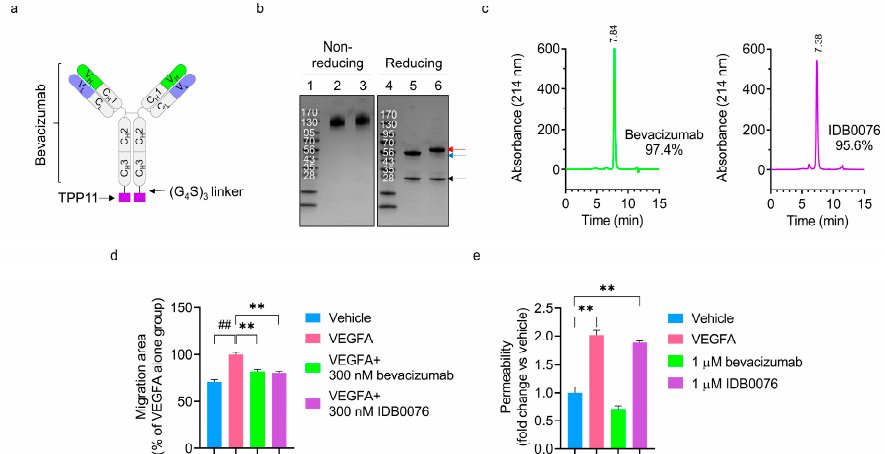
Figure 1. IDB0076 was produced in CHO-DG44 cells and characterized in comparison with bevacizumab. (a) The schematic diagram of IDB0076, in which TPP11 was fused via a 15-residue (G 4 S) 3 linker to the C-terminus of bevacizumab. (b) IDB0076 was compared to bevacizumab by SDS-PAGE analysis under nonreducing conditions and reducing conditions. Red and blue arrows indicate the heavy chain of IDB0076 and bevacizumab, respectively. The black arrow points to the light chain of IDB0076 and bevacizumab. Lanes 1 and 4: markers, lanes 2 and 5: bevacizumab, and lanes 3 and 6: IDB0076. (c) IDB0076 and bevacizumab were characterized by size exclusion high-performance liquid chromatography with monitoring at 214 nm. The left column: bevacizumab, the right column: IDB0076. (d) The vascular endothelial growth factor A (VEGFA)-induced migration assay was